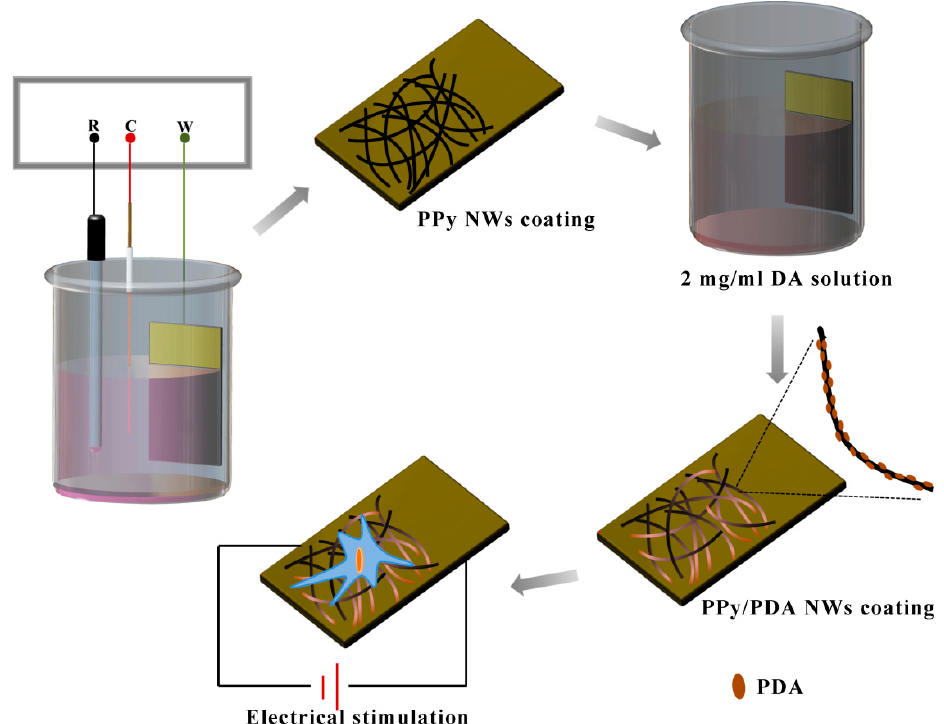
Figure 1. Illustration of preparation of PPy/PDA NWs coating and the synergistic effect with electrical stimulation on MC3T3-E1.